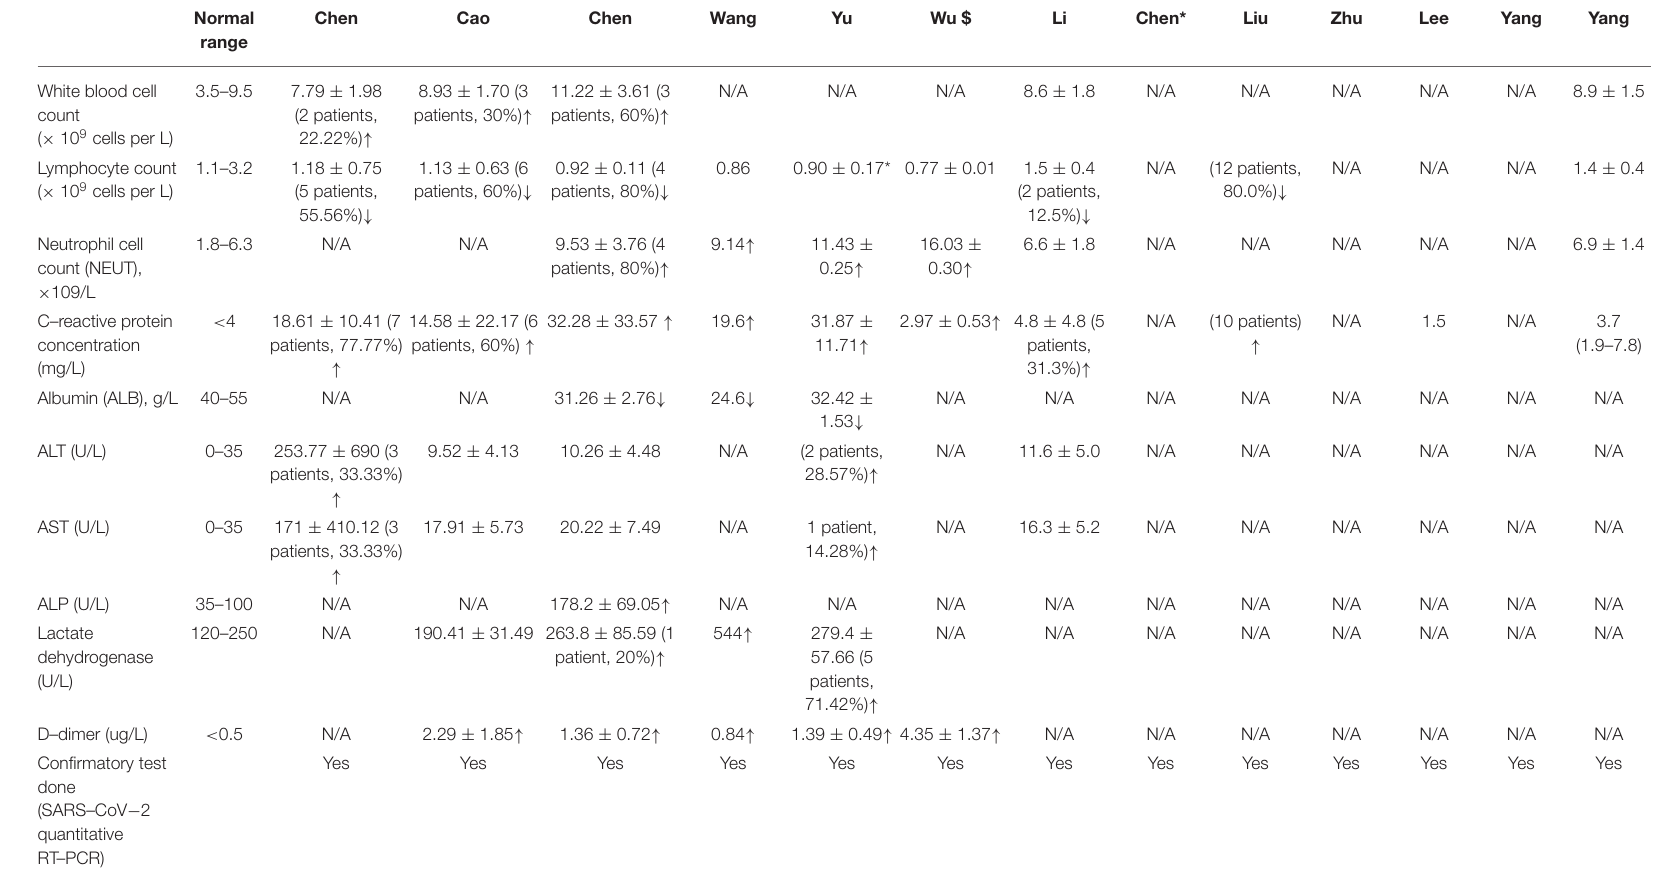
TABLE 2 | Laboratory characteristics of 235 pregnant women with COVID −